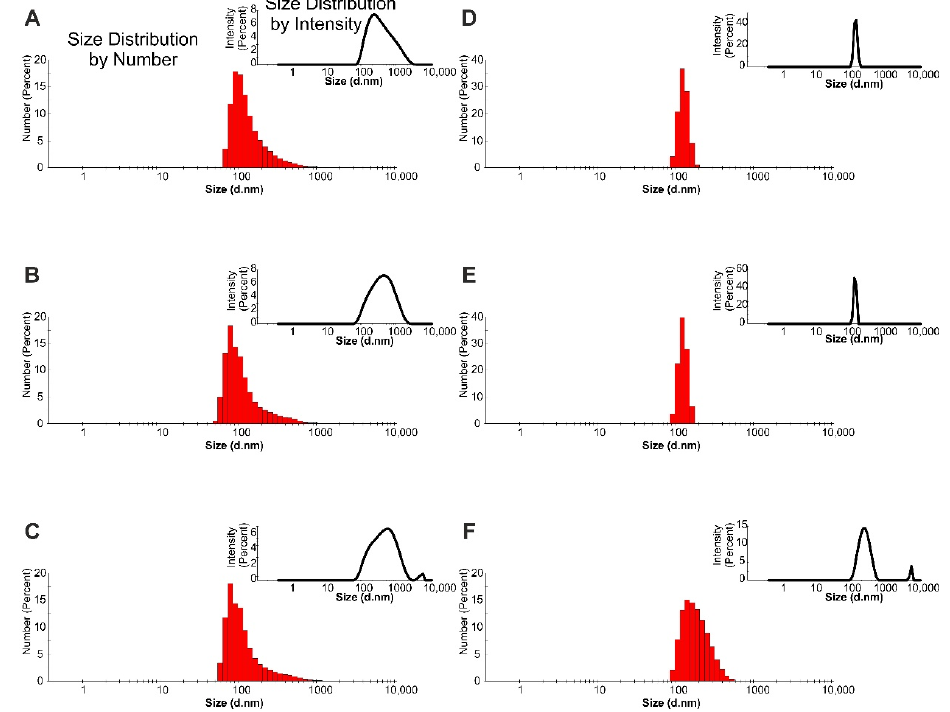
Figure 3. Droplet size distribution of the samples containing AHE (2.0 g/L) obtained with DLS measurements: ( A – C ) water solutions with 1, 2, 5% HSO content (respectively); ( D – F ) Nebudose solution with 1, 2, 5% HSO content (respectively).